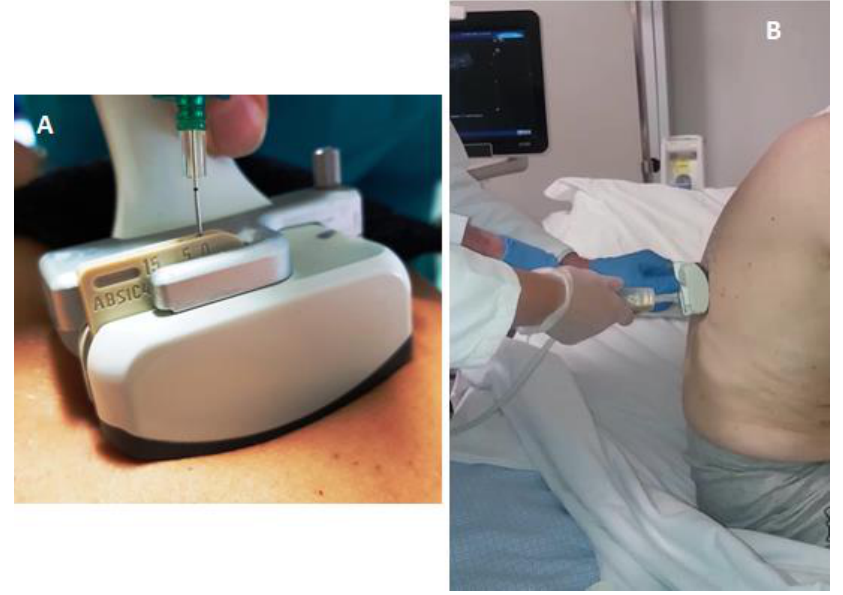
Figure 1. ( A ) Dedicated convex-array probe (5 MHz) equipped with a holed guide for needle inser- tion during interventional procedures. ( B ) Ultrasound-guided thoracentesis performed by the em- ployment of a dedicated holed convex-array with the patient in a sitting position.